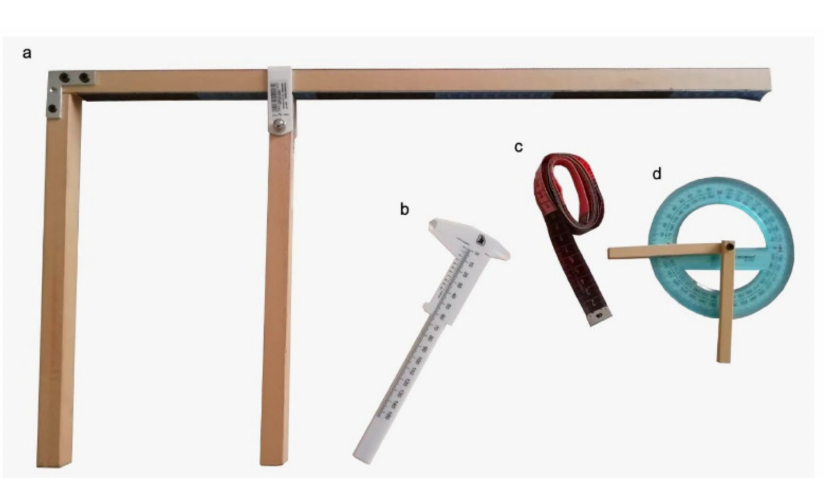
Figure 1. Measurements tools used to evaluate the thorax and body dimensions. ( a ) The basal part of the custom-made sliding gauge used to measure the height at the withers and the width and height of the thorax and the mobile part that, together with the basal part, was used to measure the height at the withers and width and height of the thorax. ( b ) The gauge used to measure the head length, nose, and head width. ( c ) The measuring tape used to measure the three thorax circumferences. ( d ) The goniometer used to measure the head’s stop